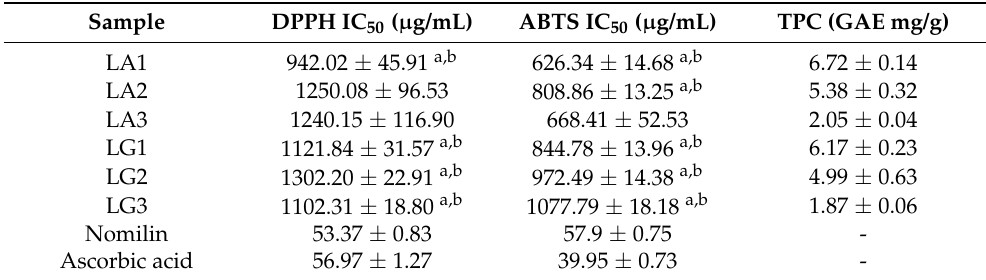
Table 1. IC 50 values of the radical scavenging activity and total polyphenol content of limonoid aglycone and limonoid